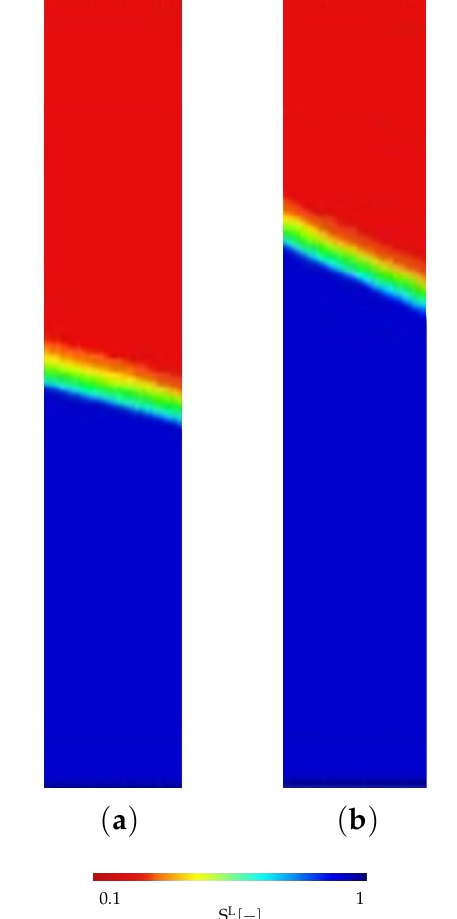
Figure 5. Water saturation degree s L at ( a ) t = 40 days, ( b ) t = 140